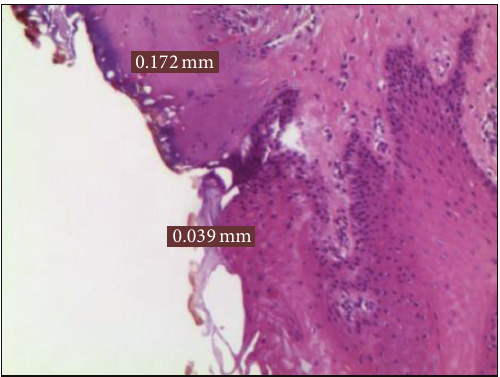
Figure 1: Histological specimen A 2 , using 2 watt in CW, colour EE, magnification from original